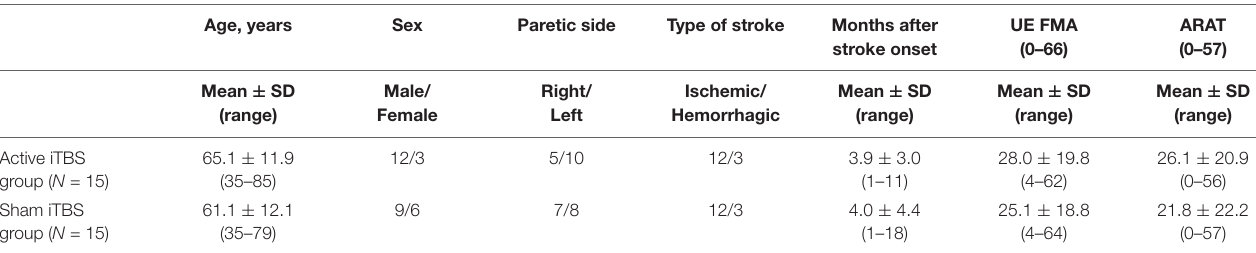
TABLE 1 | Patients’ demographic and clinical